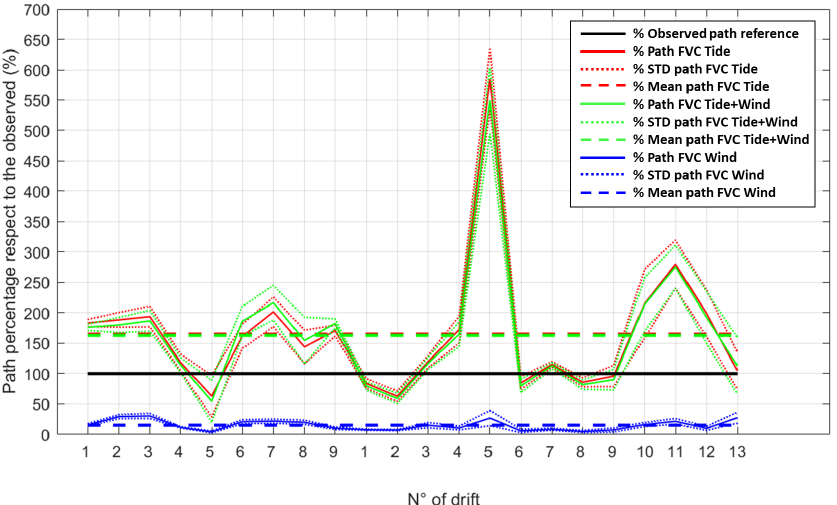
Figure 8. Drifter travel distance modeled by FVCOM (green and blue lines). The solid black line indicated the reference distance. Dashed lines indicate mean traveled distance for the cases indicated in the